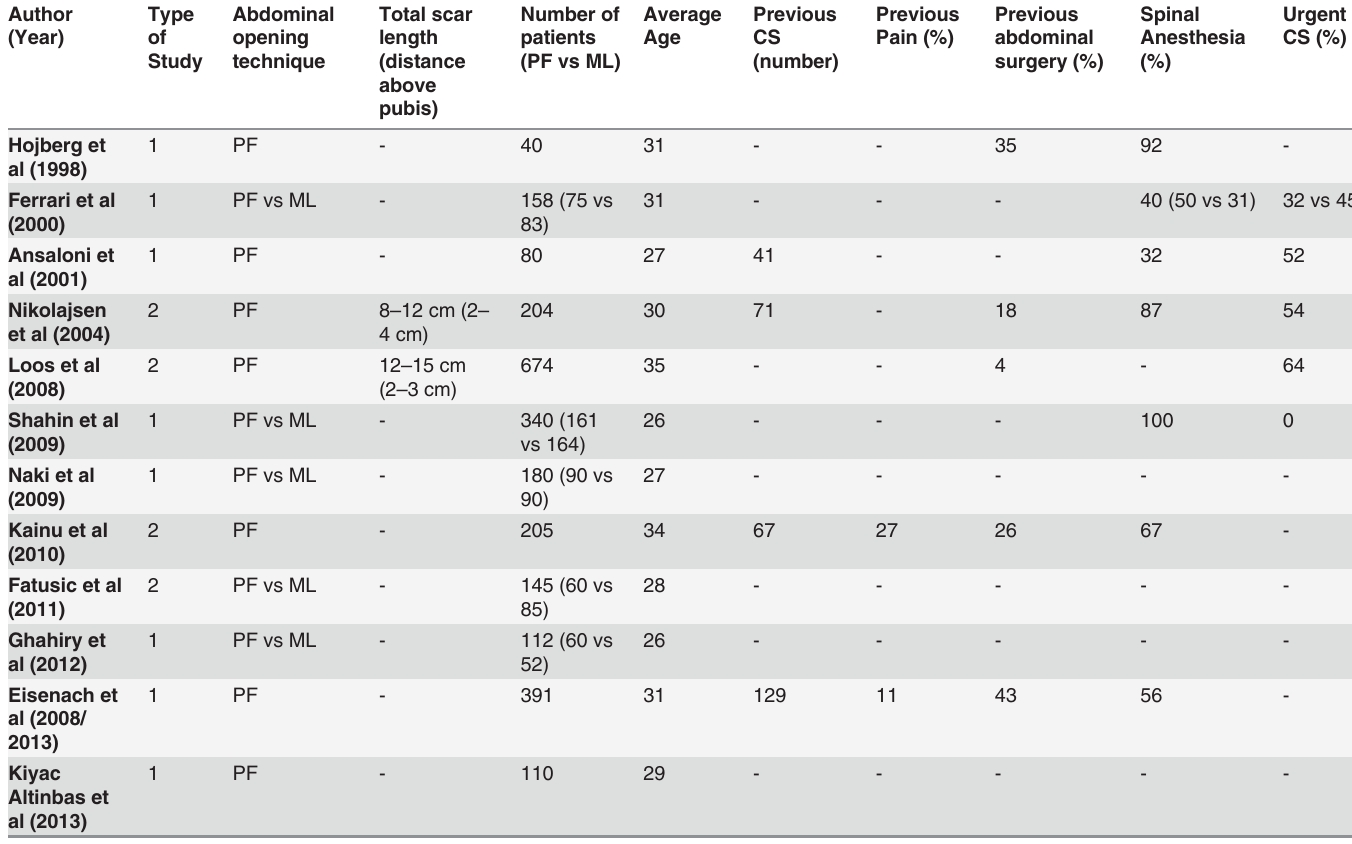
Table 1. Baseline data, study design and surgical features of the reviewed